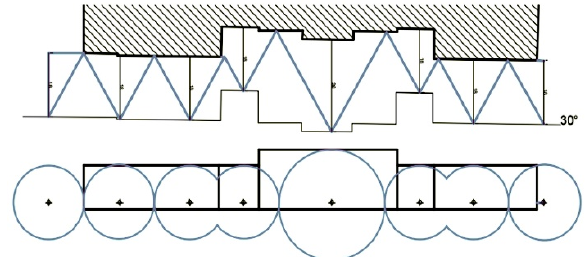
Figure 9. Plan and front view of the project scan spots with zero redundancy – graphic elaboration by Maria Chiara Pugliese For this reason, it was analyzed the values of the range of redundancy that guarantee a relatively small number of scan points and the optimal coverage of the entire building to be surveyed.